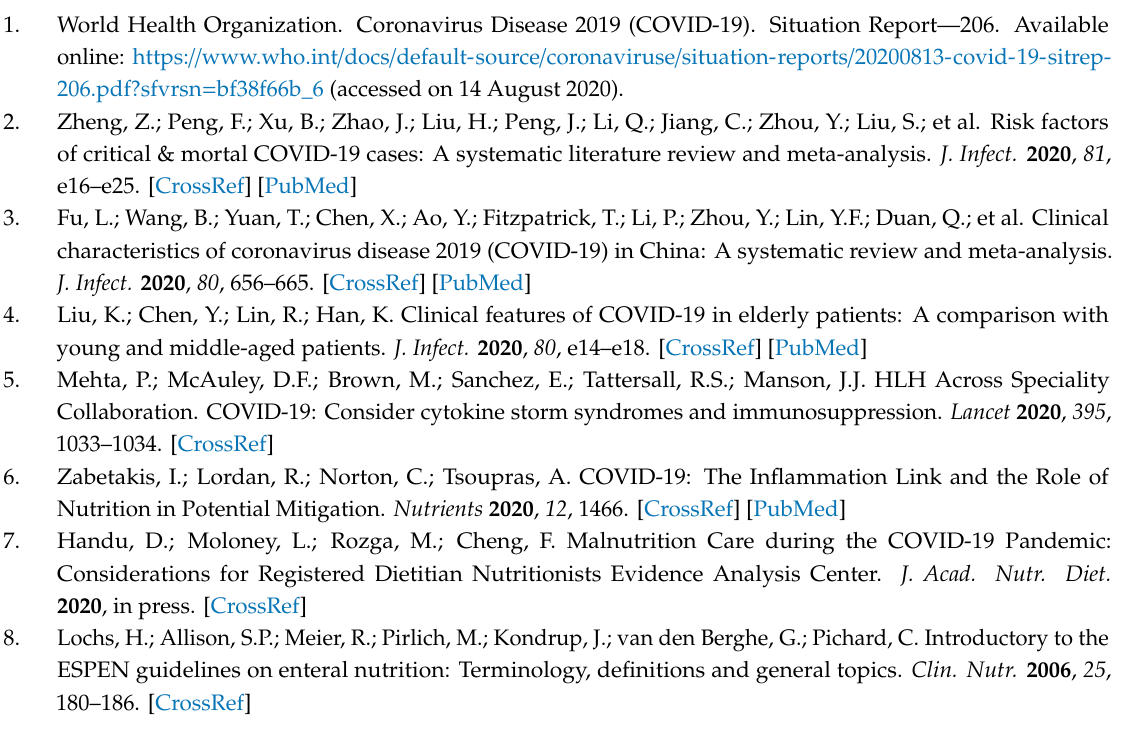
Table S1: Detailed search strategy for systematic